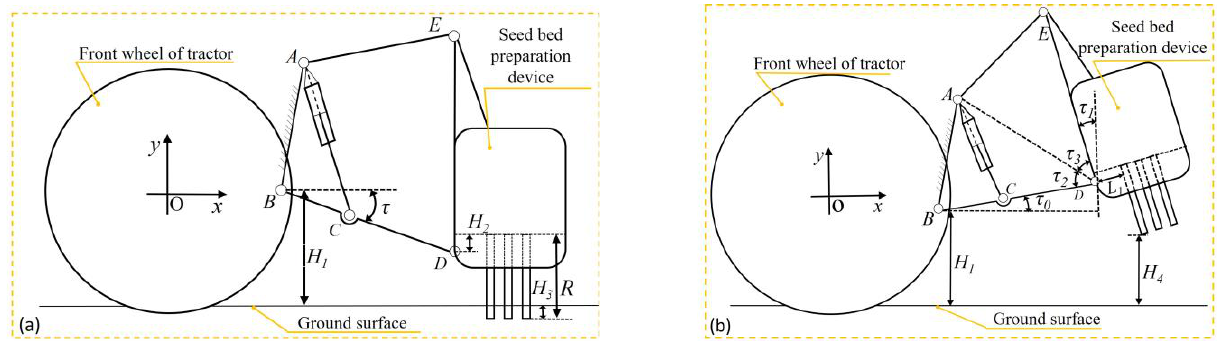
Figure 4. ( a ) Operation-state analysis. ( b ) Transport-state analysis. Referring to the existing seedbed-preparation device [18], the operation depth of straw clearing knife is designed to be 50 mm. The rotation radius of the straw clearing knife is 380 mm. The rotation center of the straw clearing knife is 100 mm higher than the hanging point of the lower tie rod. By substituting the known parameter values into Equa- tion (1), the height from the hinge point B of lower tie rod to the ground surface is not less than 238 mm, and the maximum adjustment length of the upper tie rod is more than 765 mm, meeting the design requirements.